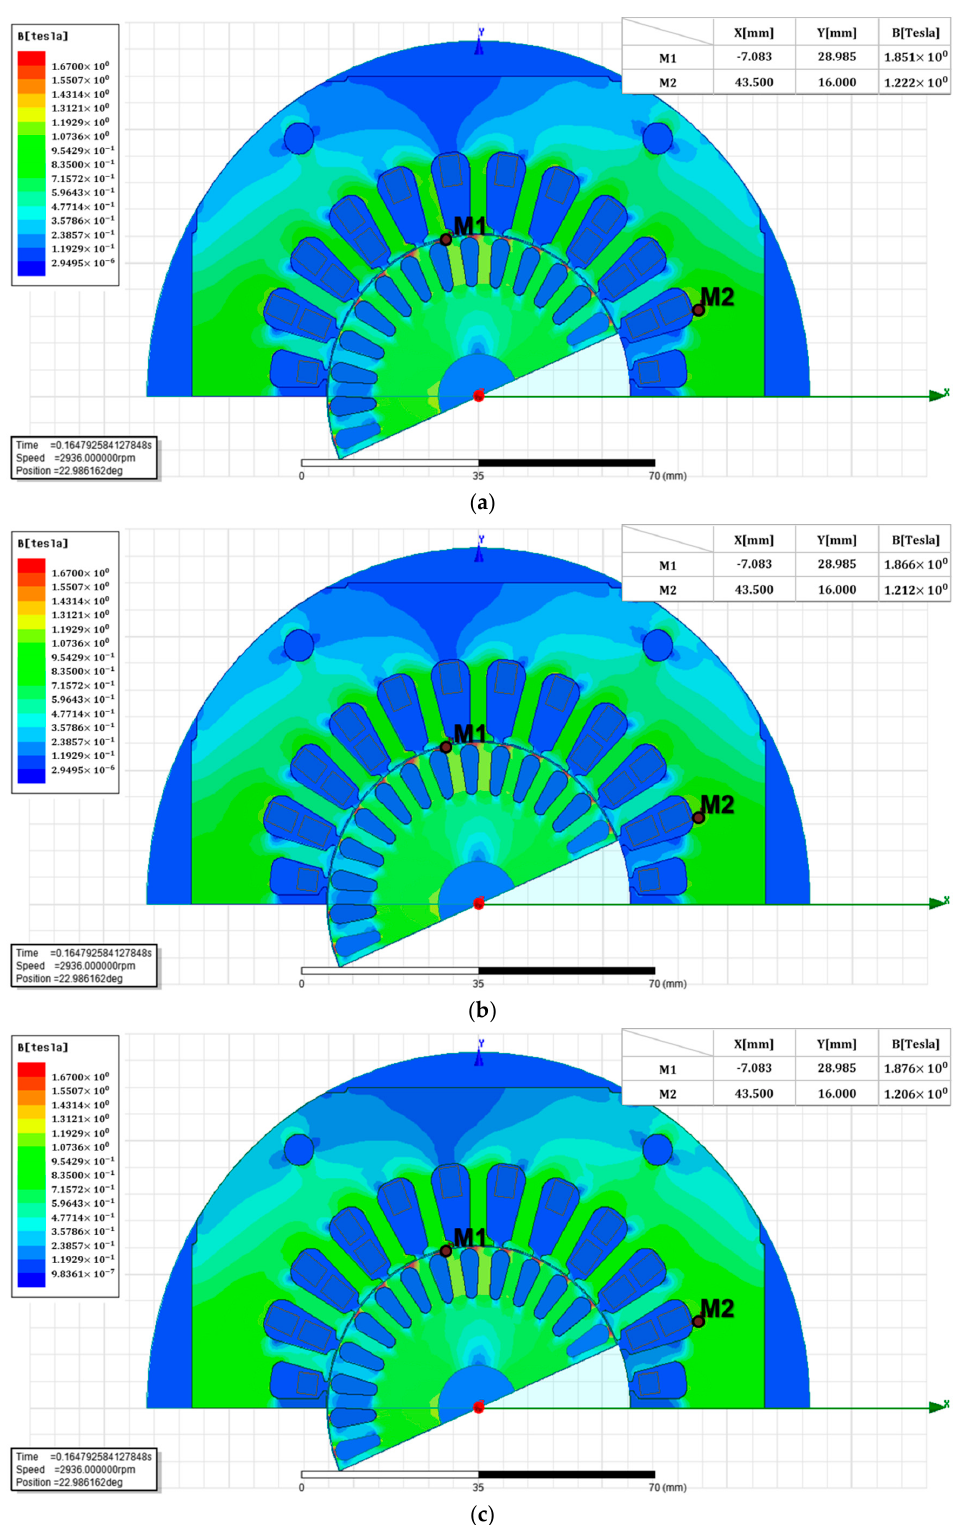
Figure 5. Magnetic flux density according to the fill factor of rotor. ( a ) 85%; ( b ) 95%; ( c ) 100%.